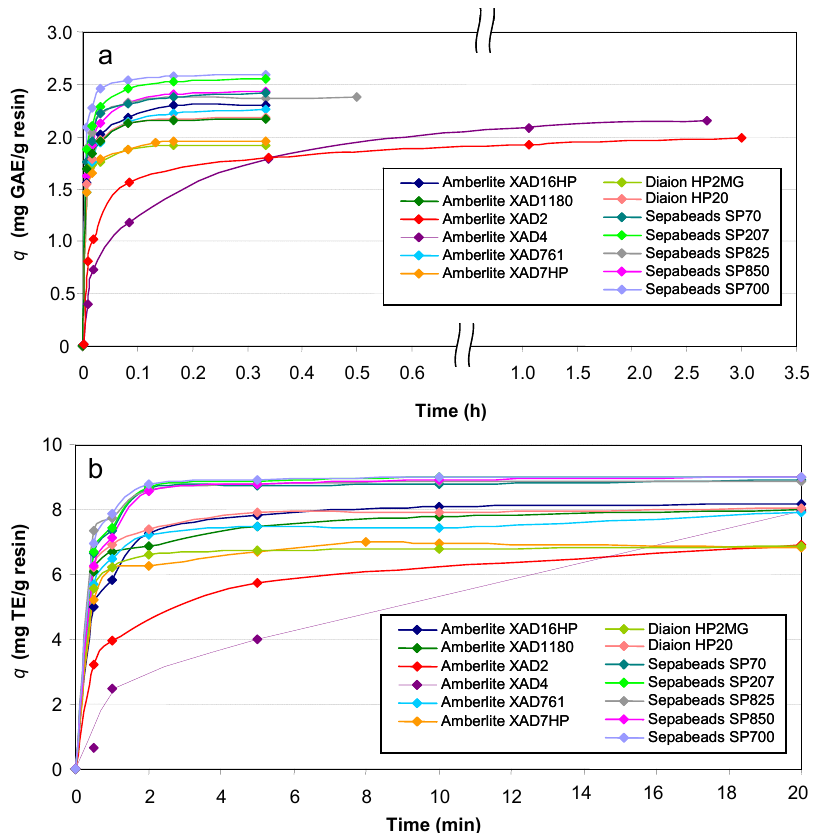
Figure 1. Adsorption kinetics of ( a ) phenolic compounds (expressed as gallic acid equivalents, GAE) and ( b ) ABTS radical scavengers (expressed as Trolox equivalents, TE) from winery wastes. The symbols correspond to experimental data and the lines to the calculated trend according to the selected